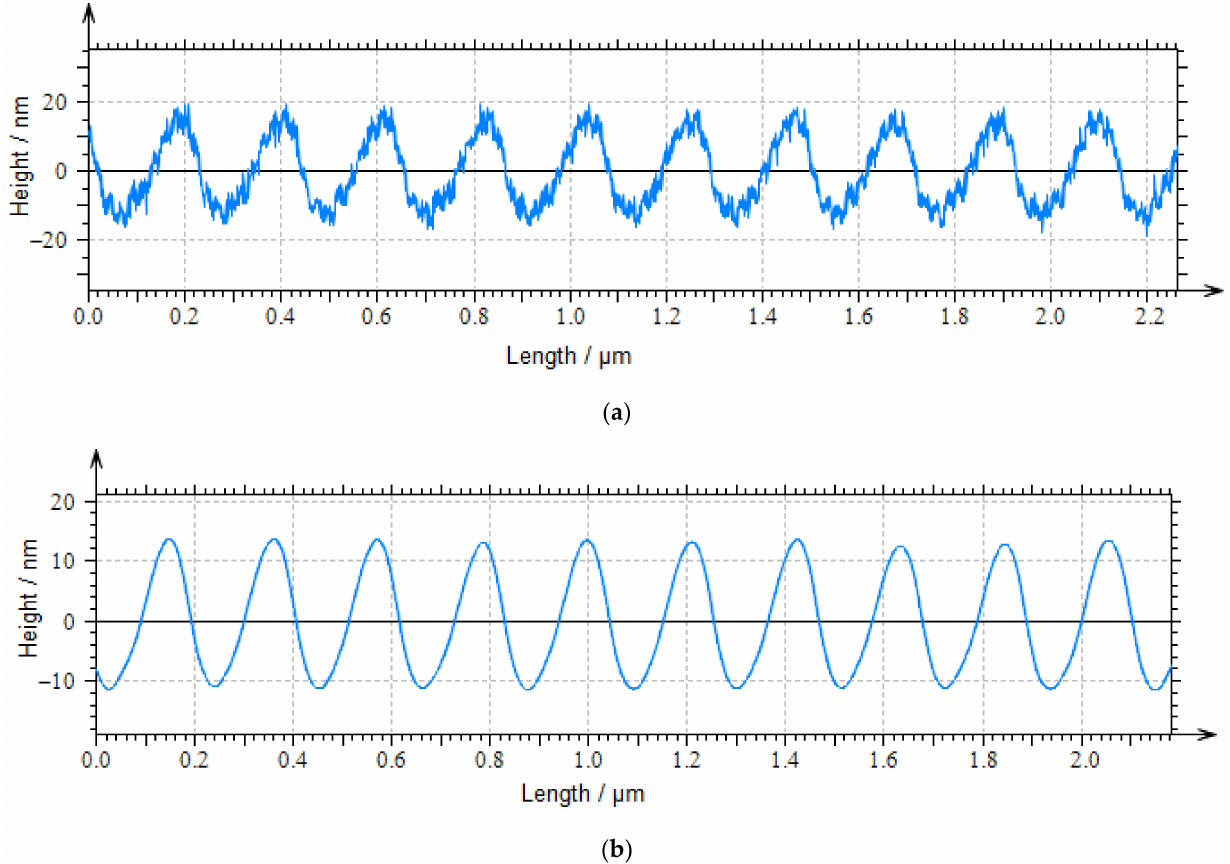
Figure 14. Profile of the grating with ten cycles: ( a ) The raw data; ( b ) The filtered data processed by Gaussian